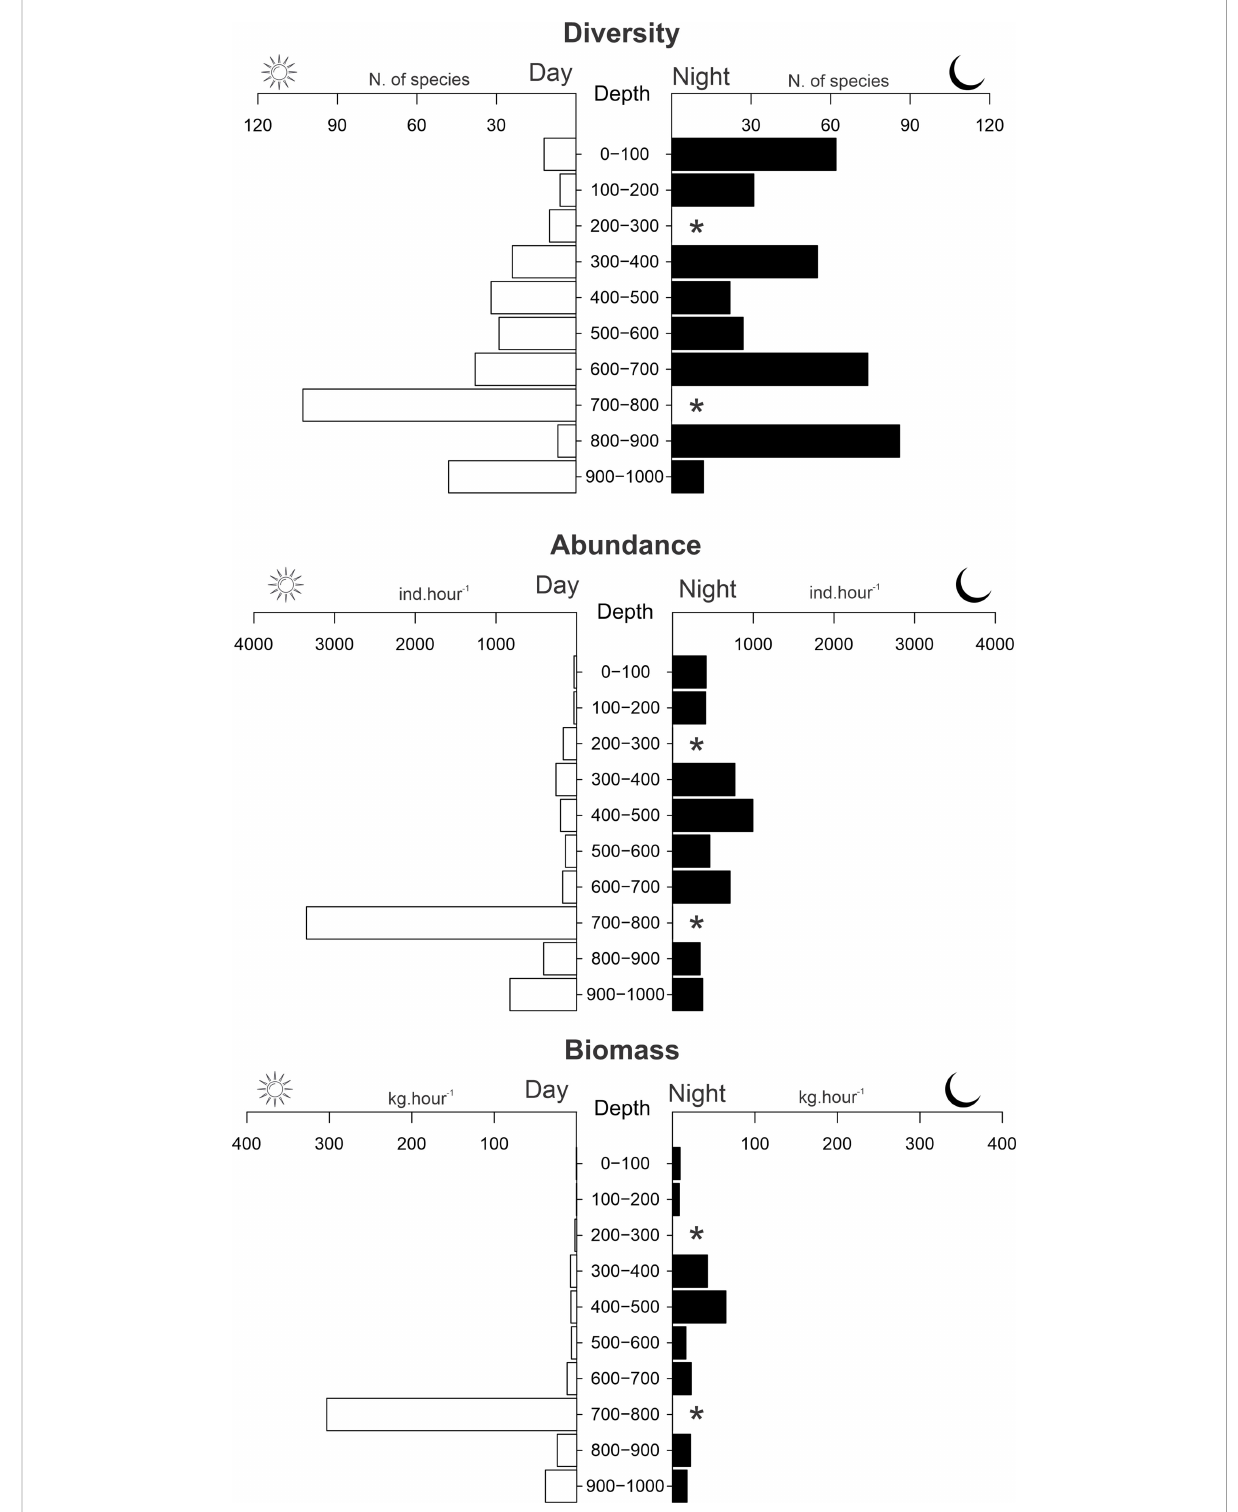
FIGURE 5 Number of species and average values of abudance (individuals.hour -1 ) and biomass (kg.hour -1 x10 2 ) of mesopelagic species of fi shes collected on the survey ABRACOS 2. *Depth strata not